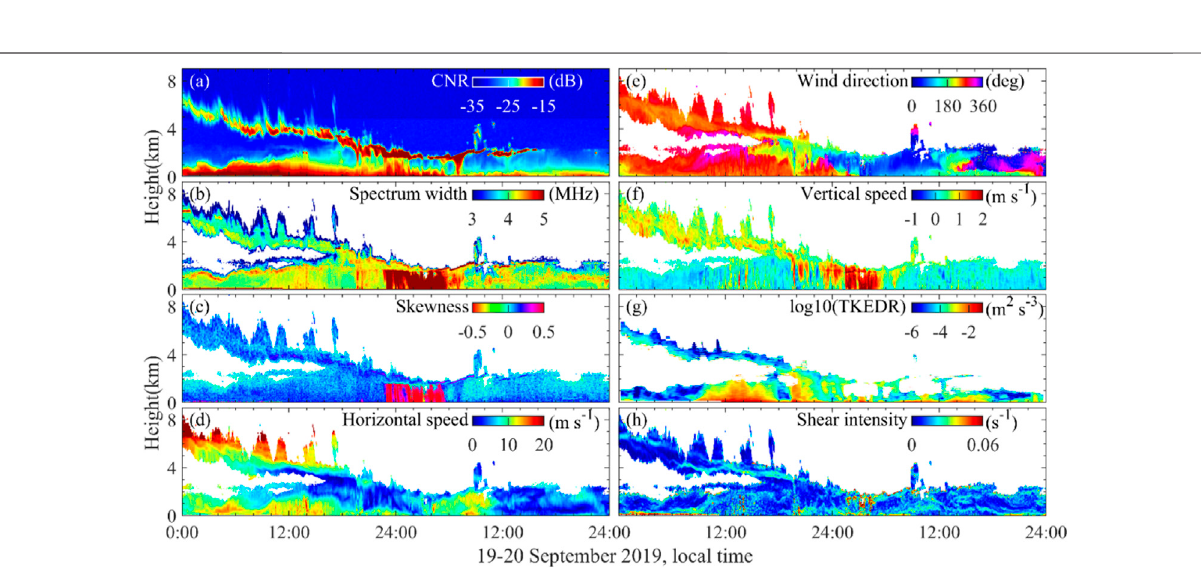
Frontiers in Remote Sensing |